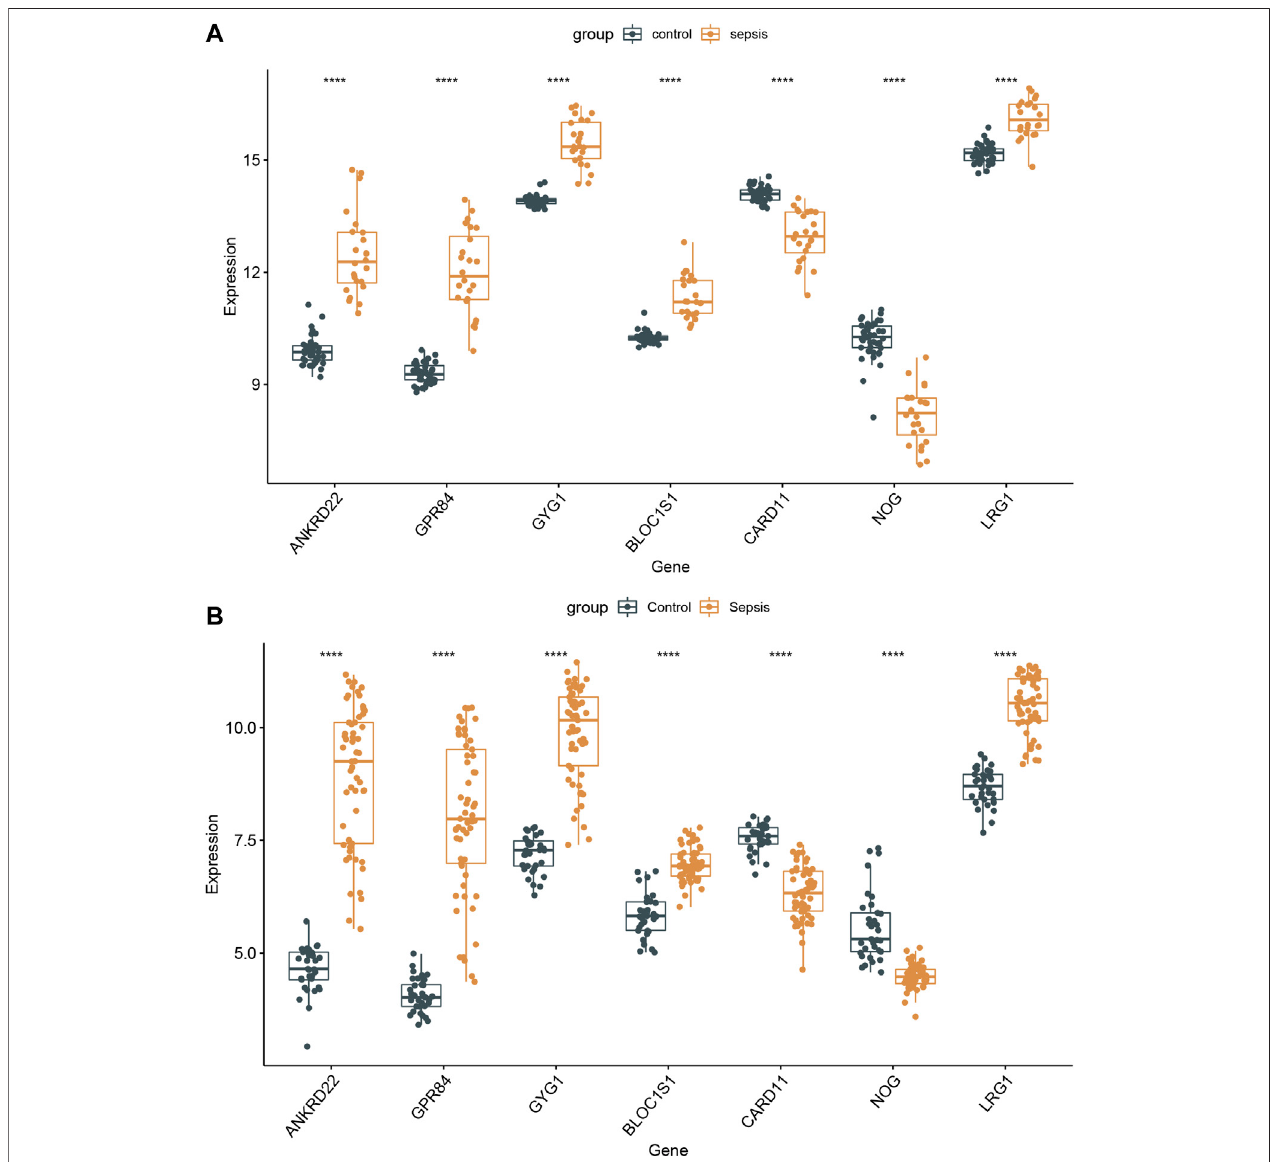
FIGURE 8 | Validation of the 7 speci fi cally expressed hub genes. (A) Veri fi cation of the expression of 7 speci fi cally hub genes in the GSE154918 dataset. (B) Veri fi cation of the expression of 7 speci fi cally hub genes in different sepsis molecular subtypes.